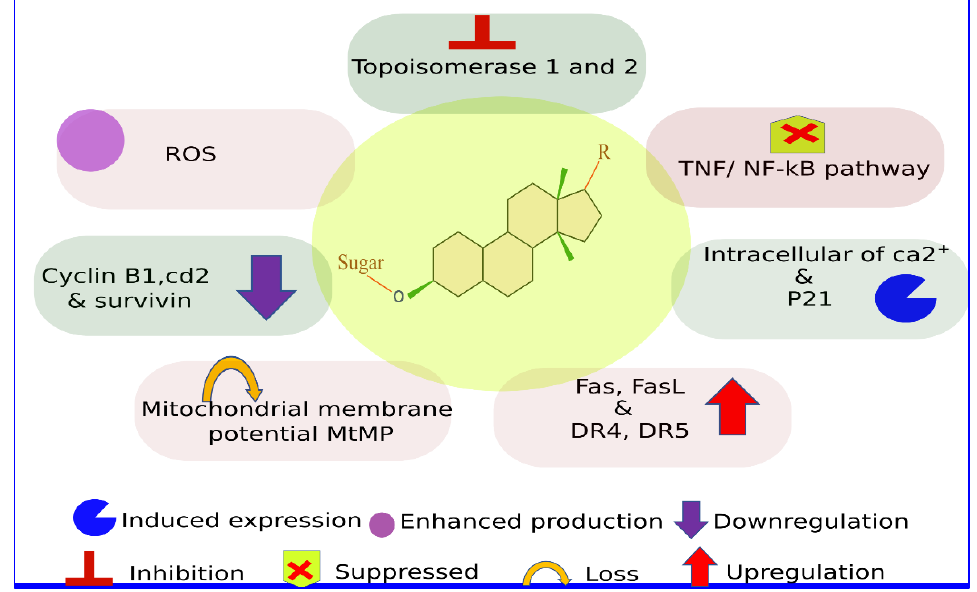
Figure 3. Molecular mechanisms for the antiproliferative and cytotoxic effects of cardiac glycosides. The antineoplastic effects of digitoxin and synthetic analog D6-MA on the NSCLC and NCI-H460 cell lines have been reported previously. Digitoxin and D6-MA arrest the cell cycle at the G2/M phase by down regulating the expression of molecular drivers